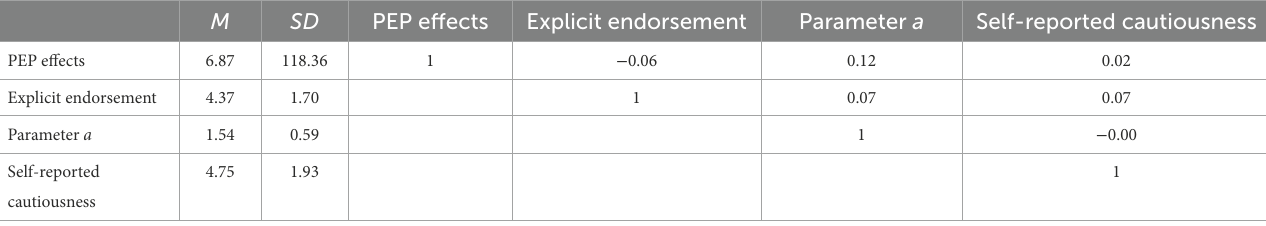
TABLE 1 Correlations between implicit and explicit endorsement of recklessness-related stereotypes in the relevant context and cautious behavior for the young group. M